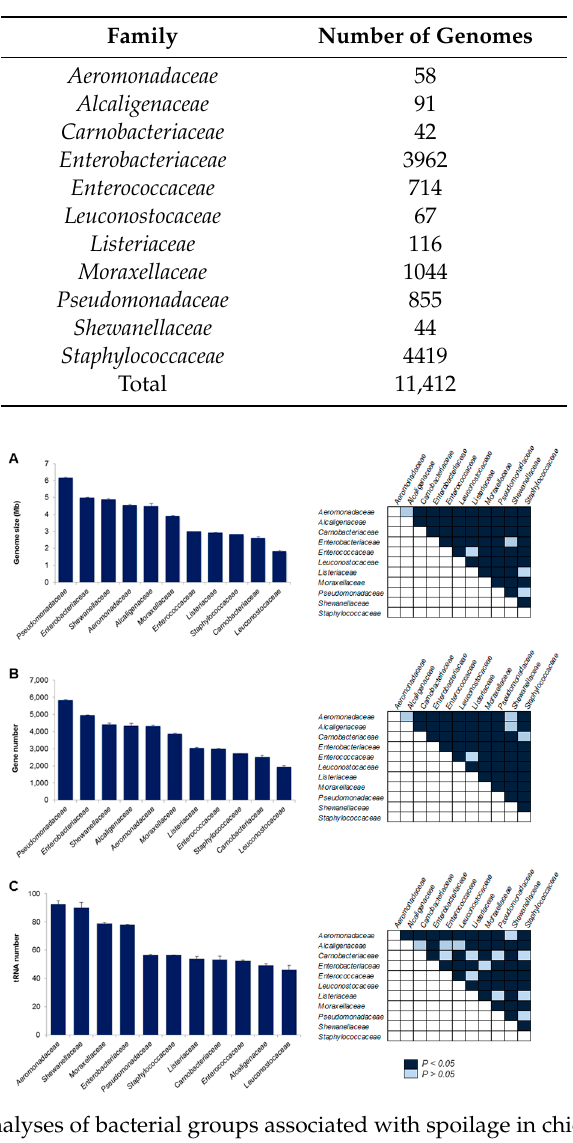
Table 2. Number of genomes analyzed for each bacterial family associated to chicken meat spoilage.